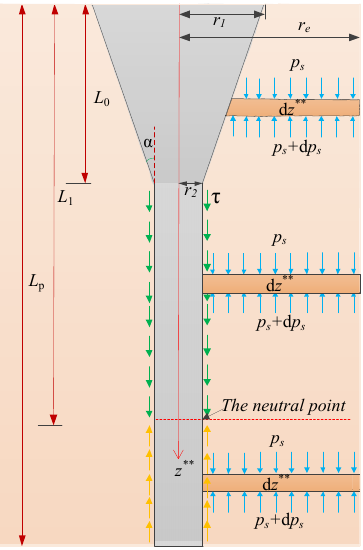
Figure 4. Load transfer model of the reinforced zone.